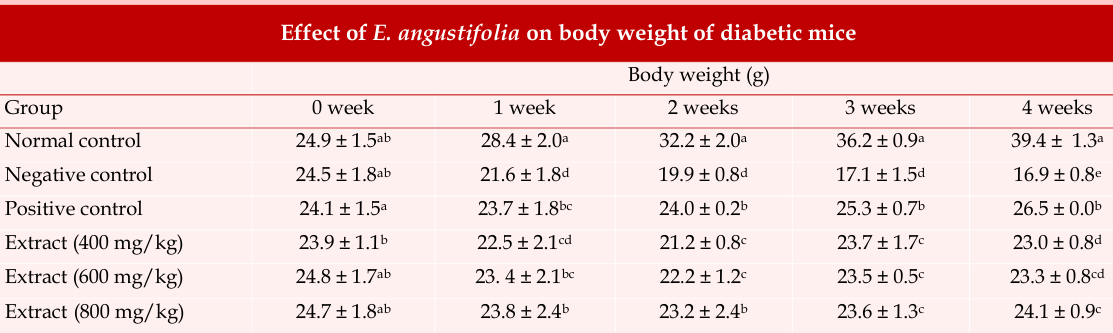
Effect of E. angustifolia on body weight of diabetic mice